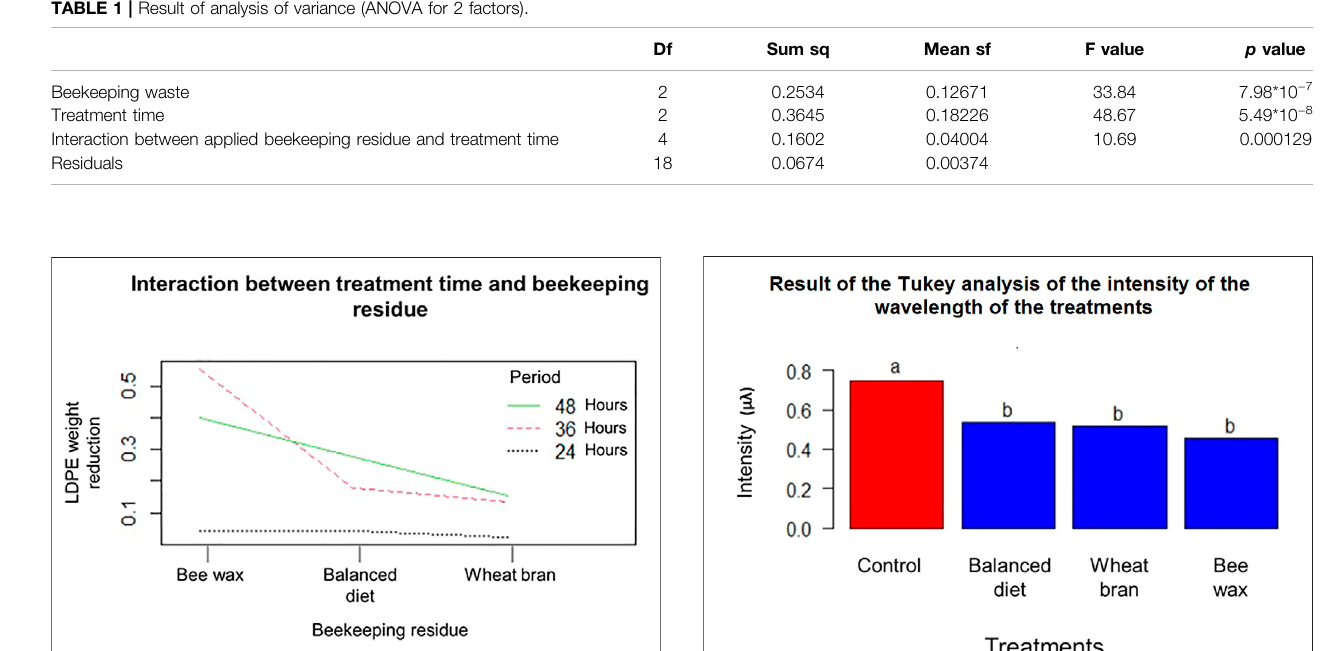
FIGURE 4 | Result of the Tukey analysis of the intensity of the wavelength of the